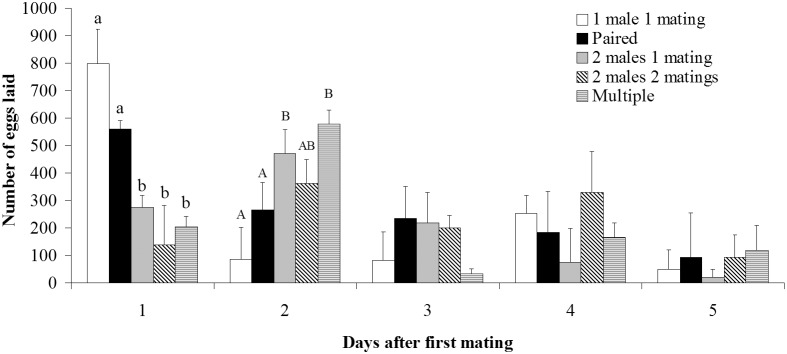
Daily oviposition patterns in relation to mating treatments in S. litura.Within the same oviposition night, bars with different letters are significantly different (P<0.05).